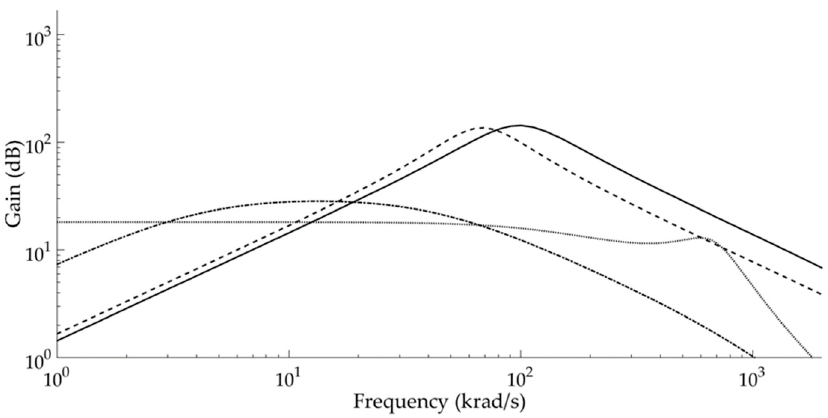
Figure 7. Amplitude–frequency characteristic for impedance: control, solid line; nettle, dashed line; carrot, dot–dashed line; elderberry, dotted line.